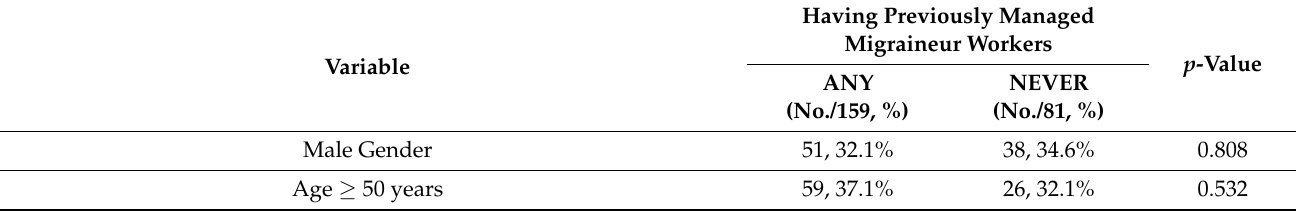
Table A1. Association of main variables with having managed migraineur workers in occupational practice by 242 occupational physicians (OP) participating into the analyses (two of them not replying to the item) (univariate analysis, chi quadred